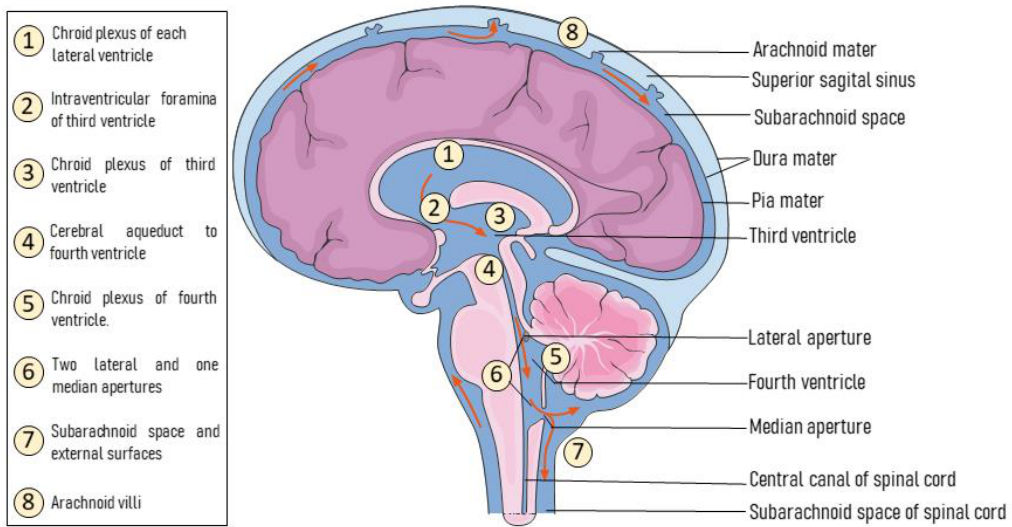
Figure 2. Schematic representation of CSF circulation. CSF is firstly secreted by choroid plexuses in each lateral ventricle (1) flowing through the interventricular Monro’s foramen into the third ventricle, where choroid plexuses (3) also add more CSF. From the third ventricle, the CSF flows through the cerebral aqueduct (4) down to the fourth ventricle, where more CSF is also added (5). Next, CSF leaves the ventricular system through two lateral apertures and one median aperture, known as foramina of Luschka and Magendie, respectively (6). CSF fills the subarachnoid space covering the external surfaces of the brain and spinal cord (7). At arachnoid villi, CSF is reabsorbed into peripheral venous blood through dural venous sinuses (8).